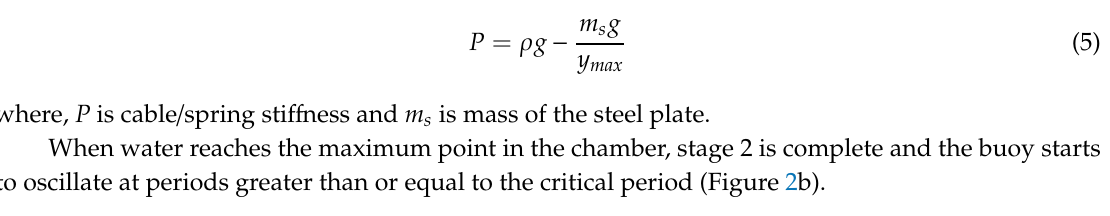
Figure 3. Optimization process for the buoy. 3. Ocean Wave Data and Resource Assessment Ocean wave data including significant wave heights and wave periods are collected and analyzed over a nine year period from a selected location in the Gulf of Mexico close to Texas [25] (Figure 4). The weather buoy from which the data is obtained is operated by the National Data Buoy Center in a location with sea depth of 84 m and coordinates of (26.968N, 96.693W). The ocean wave data is recorded every hour. Data analysis results (Table 1) show that 99% of the waves occur between 3 and 12 s wave period with a 1–5 m wave height. The data also shows that the most prevalent significant wave periods lie between 5 and 6 s and 6 and 7 s. Hence, the proposed WEC design